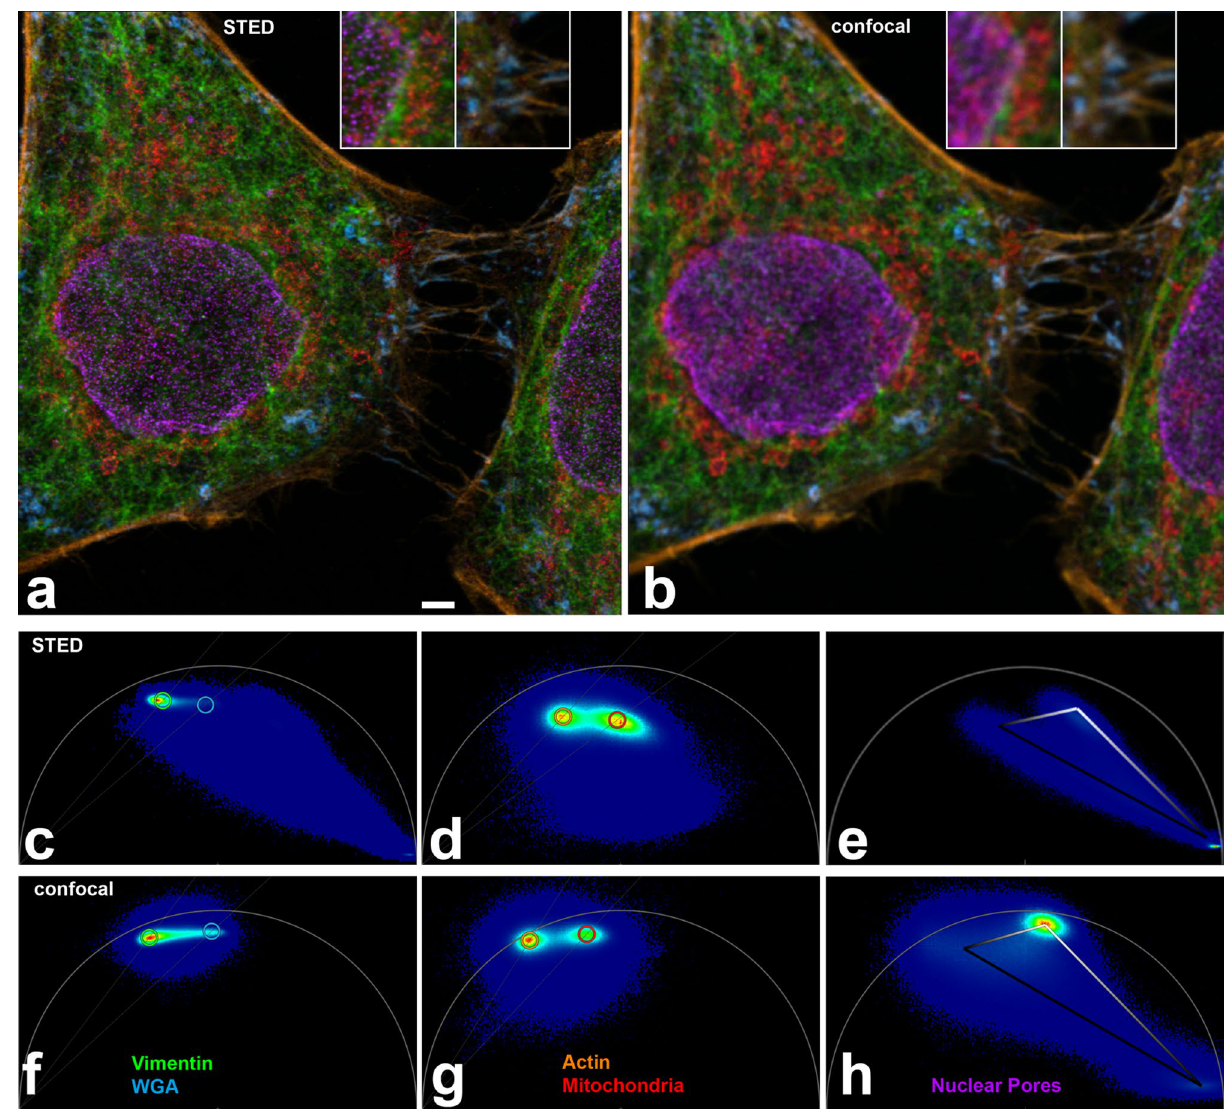
Figure 1. ( a ) Five color FLIM-STED phasor separated image. Insets show two areas doubled in size. Raw images had 1516, 1213, and 542 photons in the brightest pixels in the near red, far red and CF680R channels. Scale bar 2 µm. ( b ) Corresponding phasor separated FLIM confocal image with the same pixel size (25 nm). ( c – h ) Phasor plots from STED ( c – e ) and confocal ( f – h ) raw images corresponding to ( a , b ). Near red channel ( c , f , 600–630 nm), far red channel ( d , g , 641–680 nm) and 701–750 nm channel ( e , h ) are shown. In phasor plots, each image pixel is positioned according to its lifetime behavior. Pixels with monoexponential decay will be on the semi-circle (called ‘universal circle’), those with multiexponential decay towards the inside. Short lifetimes are to the right, long lifetimes to the left, the scale is non-linear. Note that the lifetime distribution in phasor plots in STED is shifted to the right, reflecting shorter lifetimes. For nuclear pores, the confocal phasor plot ( h ) shows pixels with crosstalk from the far red channel (compare g ) while the STED phasor plot ( e ) shows in addition strong reflection of the 670 nm excitation in the lower right corner (zero lifetime), since no notch filter was available to suppress (Tau 2.2 ns) to detect mitochondrial outer membrane protein TOMM20 and with ATTO 647N coupled to phal- loidin (Tau 3.2 ns) which delineates the actin cytoskeleton. Excitation was at 633 nm, detection at 641–680 nm. All lifetimes are given for confocal images. The near red color channel (594 nm, 600–630 nm) was populated with Alexa Fluor 594 coupled to a secondary anti-chicken antibody (Tau 2.6 ns) to visualize the cytoskeletal filament vimentin and WGA-CF594 (Tau 1.8 ns). WGA is a lectin that has a high affinity for sialic acid and N-acetylglucosamine moieties of glycoproteins and glycolipids; thus it stains the plasma membrane 24–26 . In the third spectral channel, CF680R labeled a secondary anti-mouse antibody (Tau 1.7 ns) to detect nuclear pores and was excited with the longest available wavelength, 670 nm (detection 701–750 nm). Sequential scan- ning of the three channels allowed to minimize bleed-through of fluorochromes to neighboring spectral channels